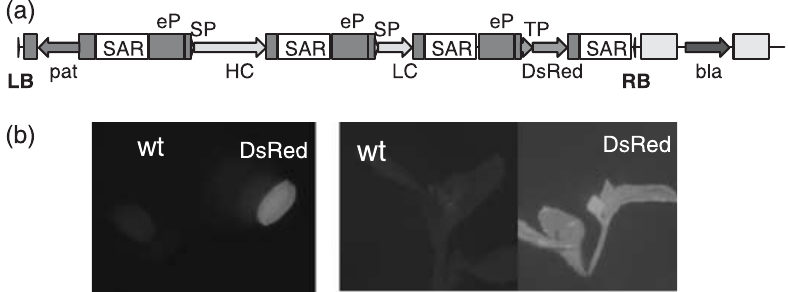
Figure 2 (a) Plant expression vector used for the expression of immunoglobulin G (IgG) antibodies: bla, ampicillin resistance gene; DsRed, red fluorescent protein; eP, enhanced cauliflower mosaic virus (CaMV)-35S promoter; HC, LC, heavy and light chain; LB, RB, left and right border; pat, basta resistance gene with promoter and terminator of the nopaline synthase gene; SAR, scaffold attachment region; SP, signal peptide; TP, transit peptide. (b) Seeds and seedlings examined under fluorescence microscopy: DsRed, seed transformed with the binary vector described above; wt, non-transformed seed.